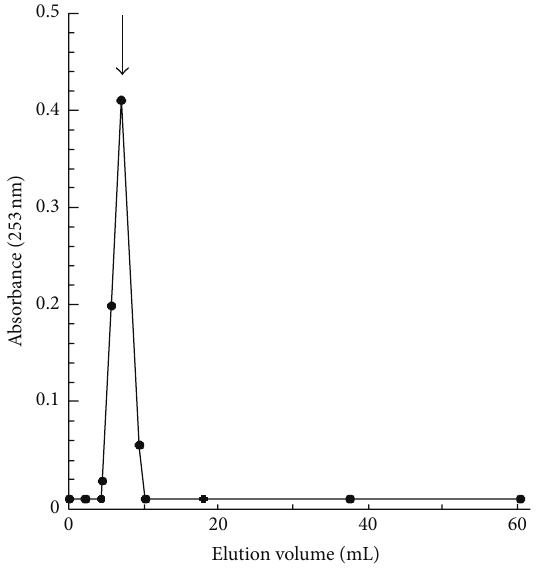
Figure 5: Elution profile of #PC9-Ch1-ive1.0 liposomes on Sepha- rose 4B gel-filtration column (length: 10cm, diameter: 1cm, and flow rate: 160 𝜇 L/min). The amount of ivermectin associated with liposomes was determined from the optical density at 253 nm. The solid arrows indicate void volume fractions, including liposome- entrapped ivermectin.